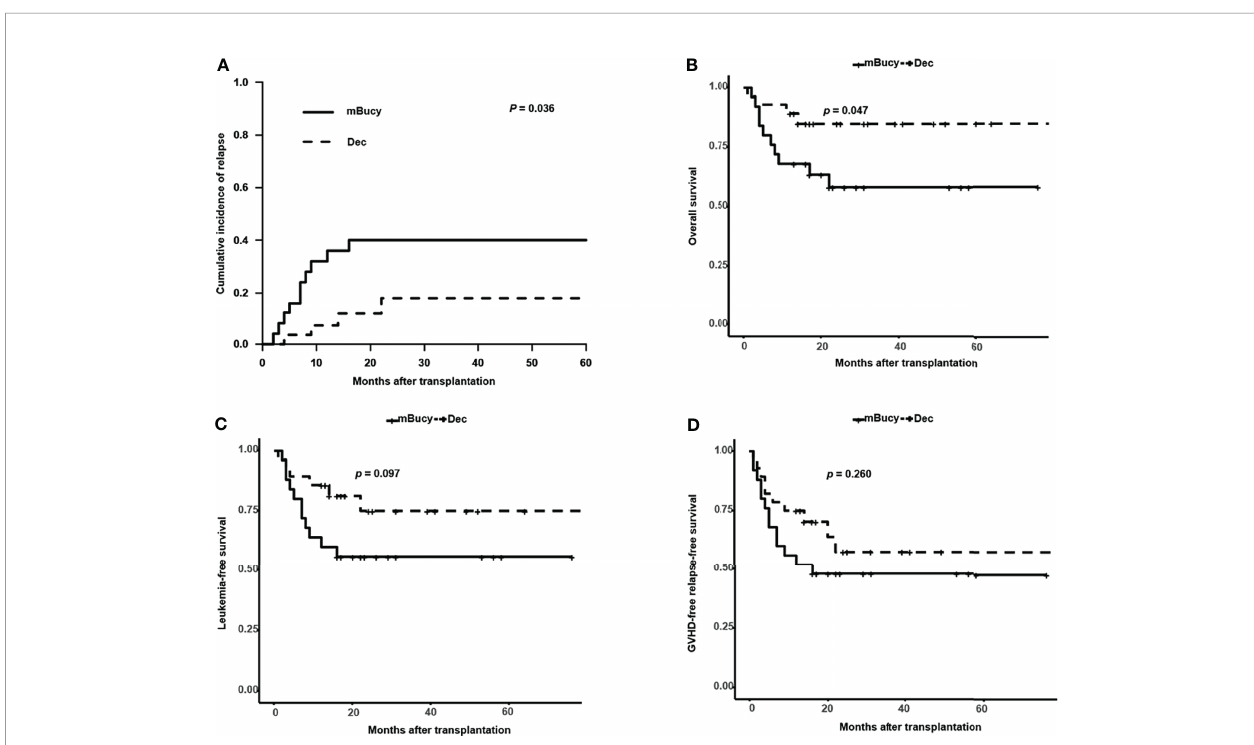
FIGURE 4 | Outcomes in patients undergoing haploidentical donor (HID)-hematopoietic stem cell transplantation (HSCT). (A) Cumulative incidence of relapse. Probability of (B) overall survival, (C) leukemia-free survival, and (D) graft-versus-host disease (GVHD)-free relapse-free